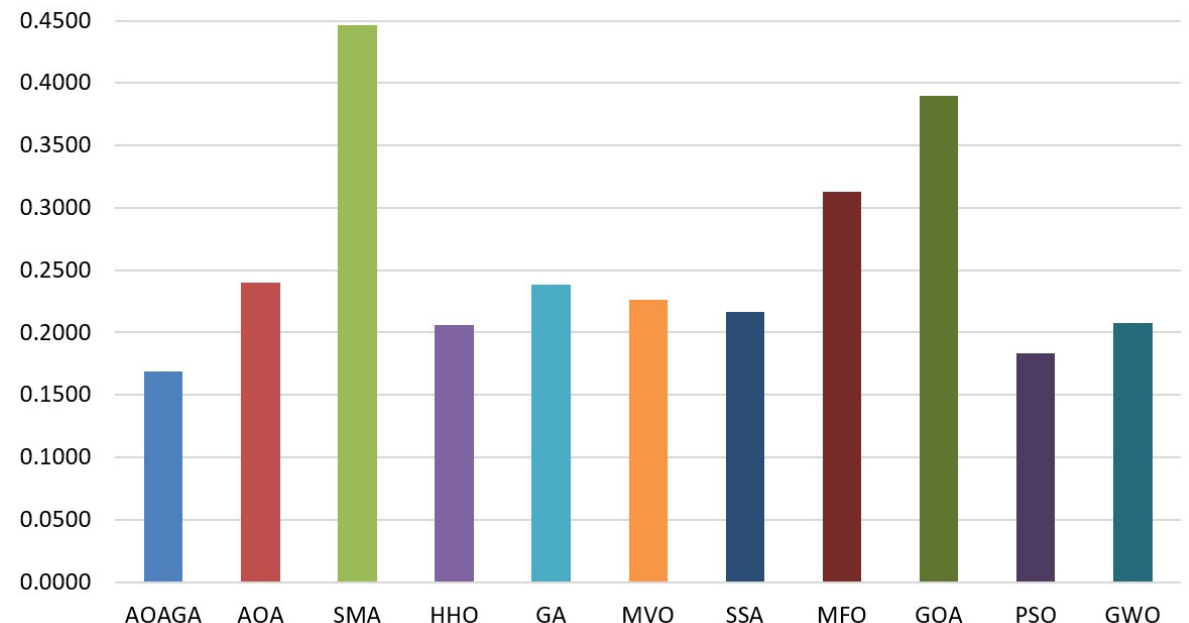
Figure 3. Average of the fitness values for all algorithms.